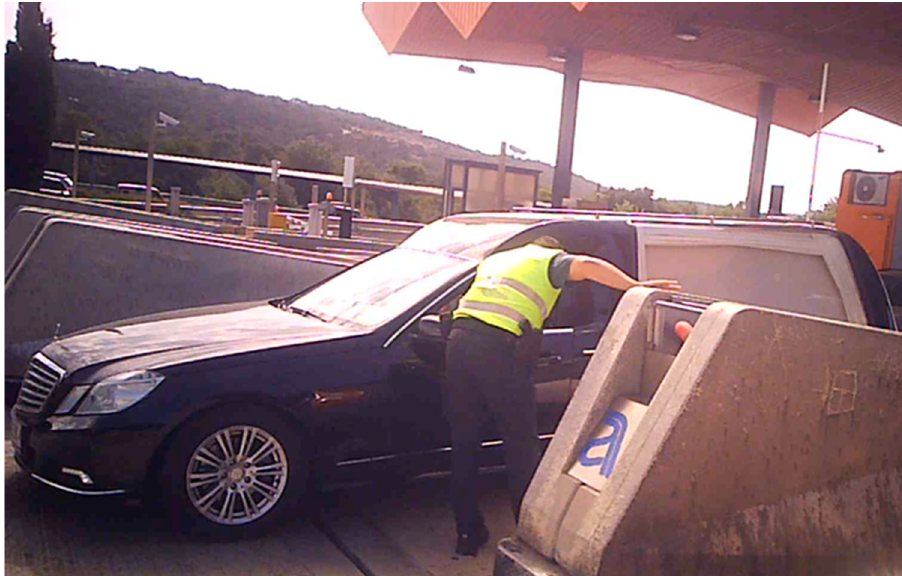
Figure 5. A police officer stops a hearse at the AP-7 tollbooth (authors’ data